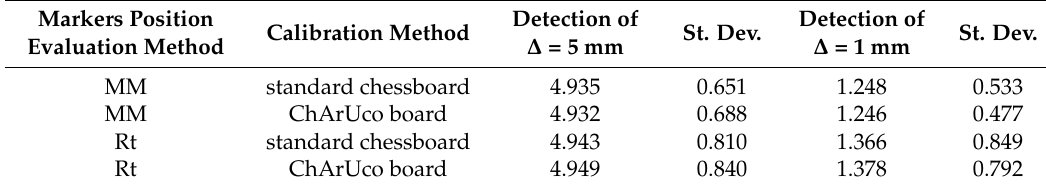
Table 2. Mean values of distance variations ( ∆ = 5 mm and ∆ = 1 mm) evaluated using two methods: (MM) the SLAM as in [17]; (Rt) computing the 3D translation vectors directly from the camera pose parameters. In both cases, the camera was calibrated by using the standard chessboard and the ChArUco